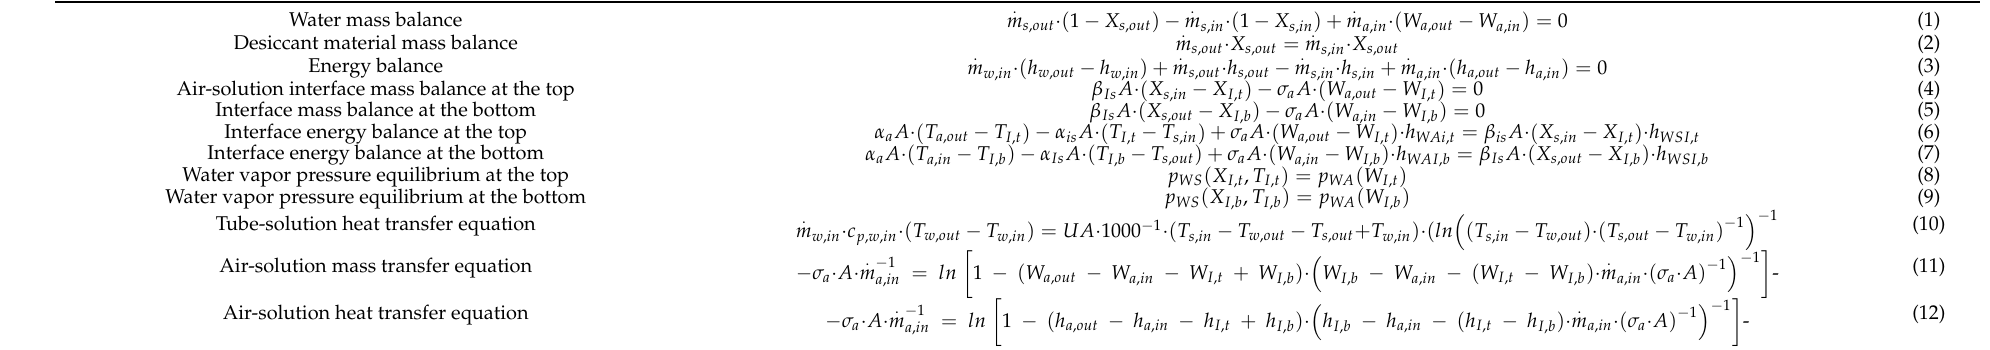
Table 1. Equations used for modeling the air-solution contactors (adapted from